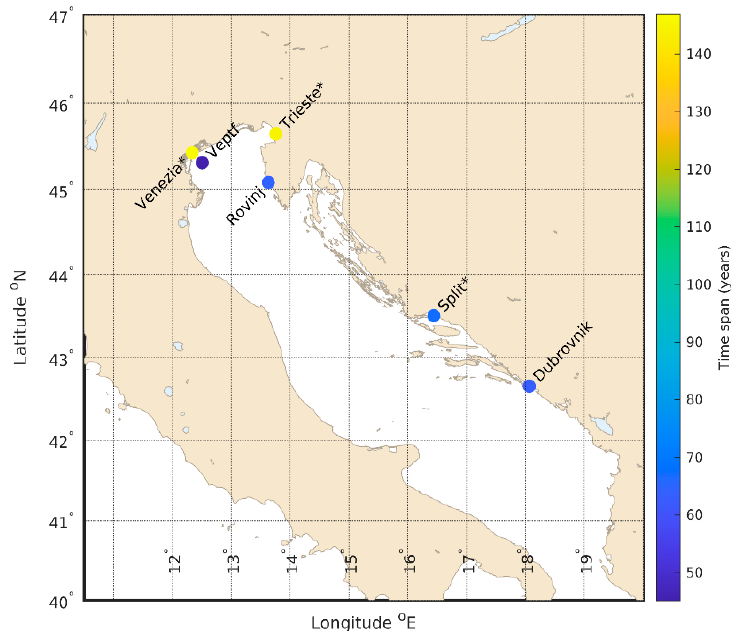
Figure 1. Positions of six tide gauges in Adriatic Sea. Color bar indicates length of available time series of sea level at tide gauges; shortest time series is about 50 years.